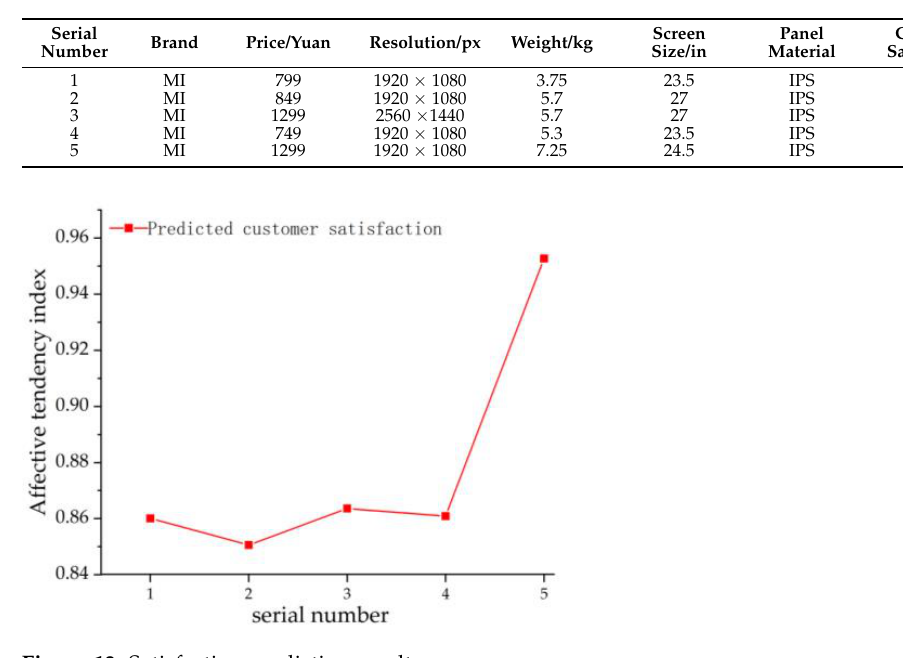
Figure 13. Satisfaction prediction results. Table 5. Experimental verification data.